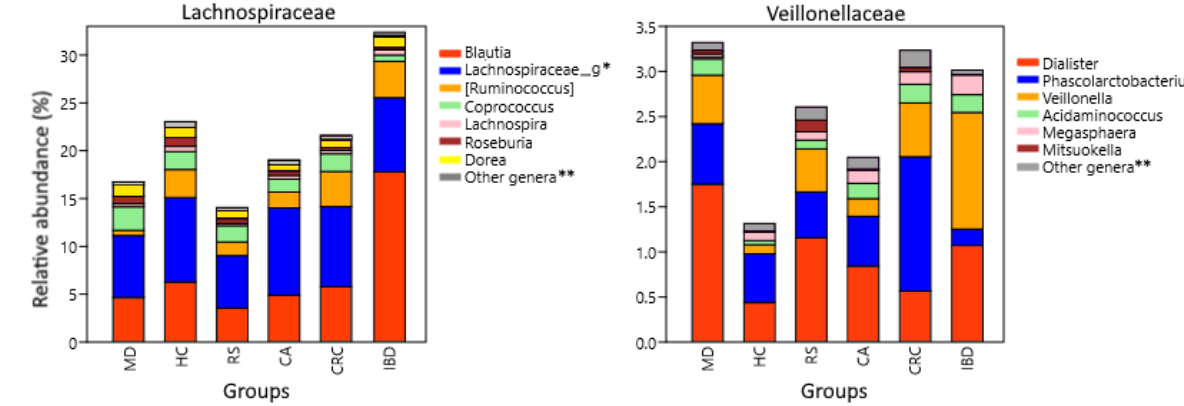
Figure 5. Lachnospiraceae and Veillonellaceae composition at genus level. Relative abundance corresponds to the average percentual fraction of reads in the group representing each OTU. Groups: Subjects following a Mediterranean diet (MD), healthy subjects (HC), subjects at risk of developing colorectal cancer (RS). Patients with colon adenoma (CA), colorectal cancer (CRC), or inflammatory bowel diseases (IBD). * Genus or genera unannotated in the reference database. ** Less abundant genera and sequences that could not be classified at the genus level.